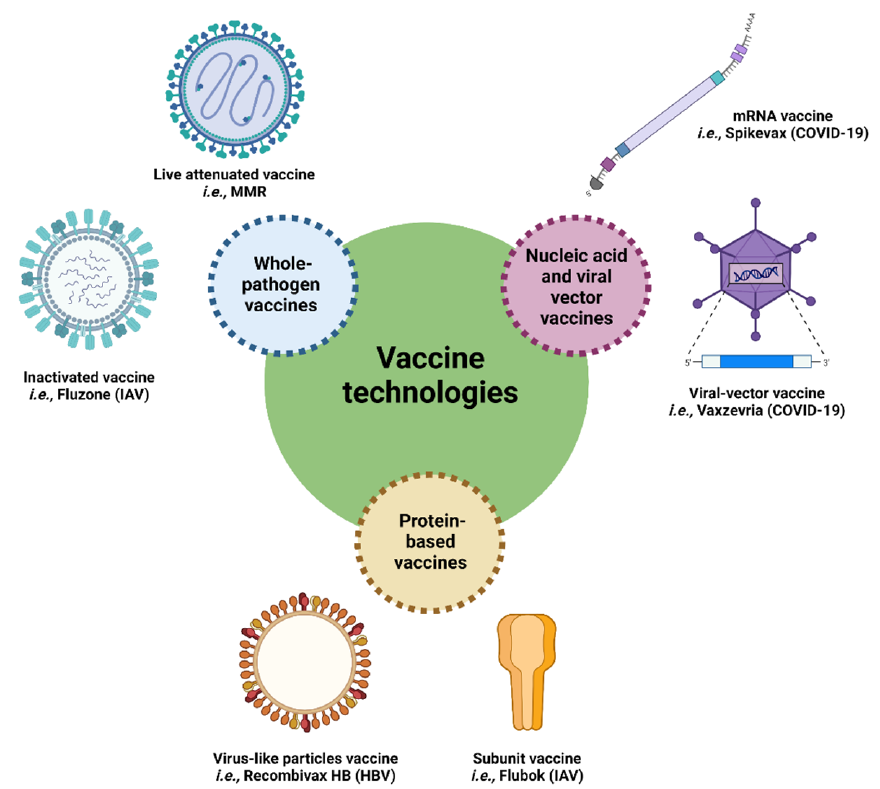
Figure 2. Schematic representation of vaccine technologies and examples of commercialized vaccines for human use. HBV: hepatitis B virus; IAV: influenza A virus; MMR: measles, mumps, and rubella.